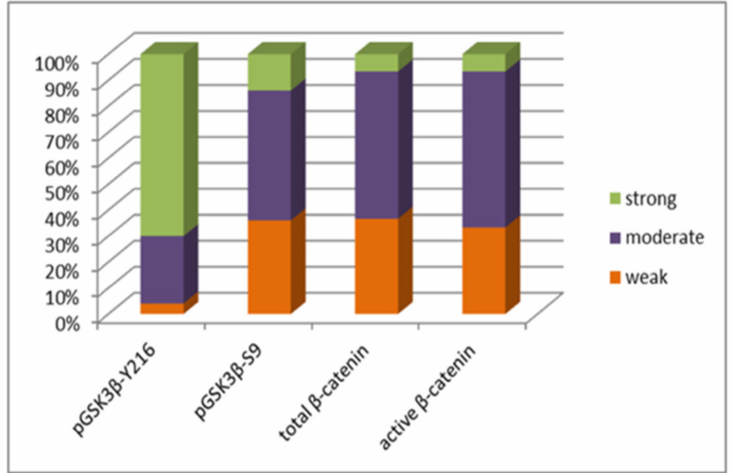
Figure 4. Graph illustrating the levels of expression of active (pGSK3 β -Y216) and inactive (pGSK3 β - S9) forms of GSK3 β investigated in our total astrocytoma sample; and levels of expression of both forms of β -catenin (total and active) in glioblastoma